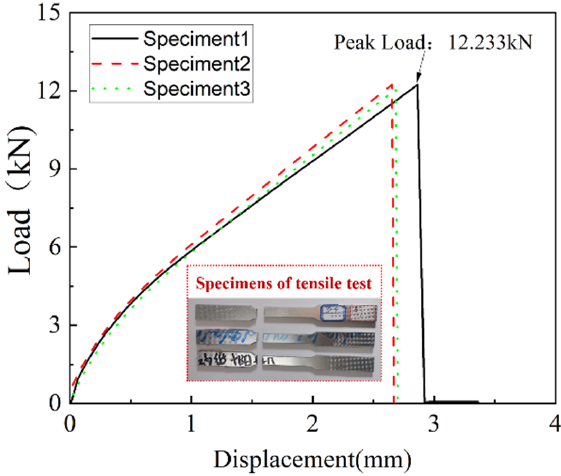
Figure 10. Load versus displacement curves of tensile test.